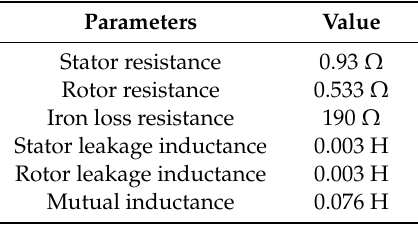
Table A2. Parameters of 3kW